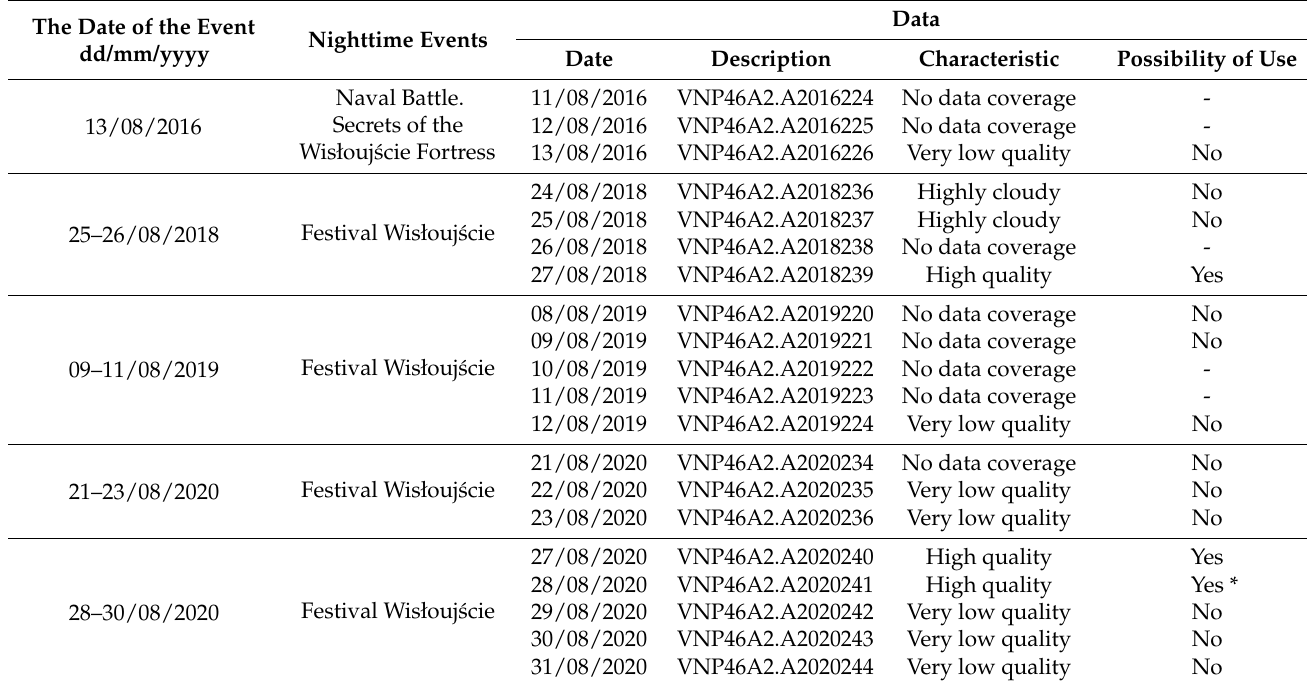
Table 5. List of dates of events including nighttime illumination organised in the area of the Wisłoujscie Fortress together with the availability of the analysed data. Source: authors’ elaboration.